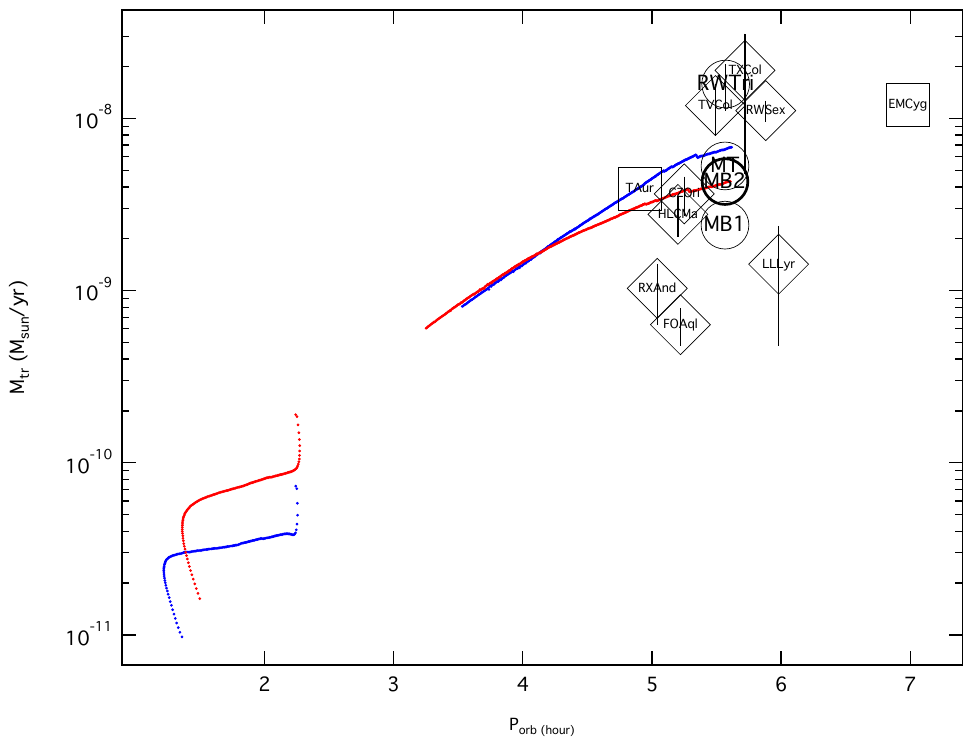
Figure 3. Mass transfer rates as a function of the orbital period. The red and blue lines refer to the mass transfer rates derived by the standard and revised models [42], respectively. The CV names represent the CVs with the orbital periods similar to that of RW Tri listed in Table 3. The texts of MT, MB1, and MB2 inside the open circles represent ˙M MT , ˙M MB1 and ˙M MB2 of RW Tri calculated in this paper, respectively. The mass transfer rates denoted by the diamonds are listed in Table A.2 in Dubus et al. [44], while those denoted by the rectangles are derived from their corresponding O-C